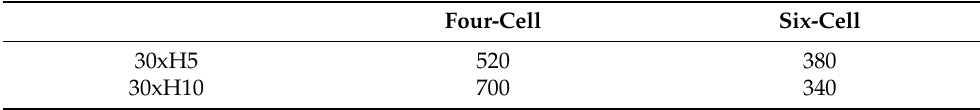
Figure 9. Force–displacement curve for actuators with varying number of cells and skeleton heights (H) given an actuating pressure of − 40 kPa. The curves for actuators with 4 cells are shown in ( a ) and those with 6 cells in ( b ). The linear fit slopes of these curves were used to estimate a linear stiffness for each actuator using Hooke’s law.